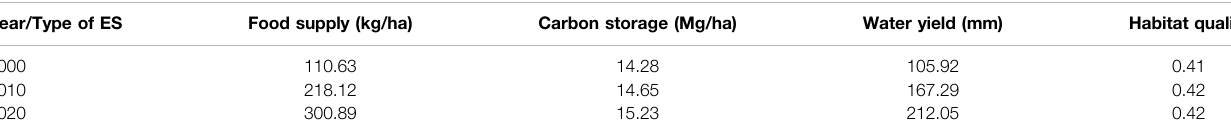
TABLE 1 | Change in average ESs of Ordos from 2000 to 2020.